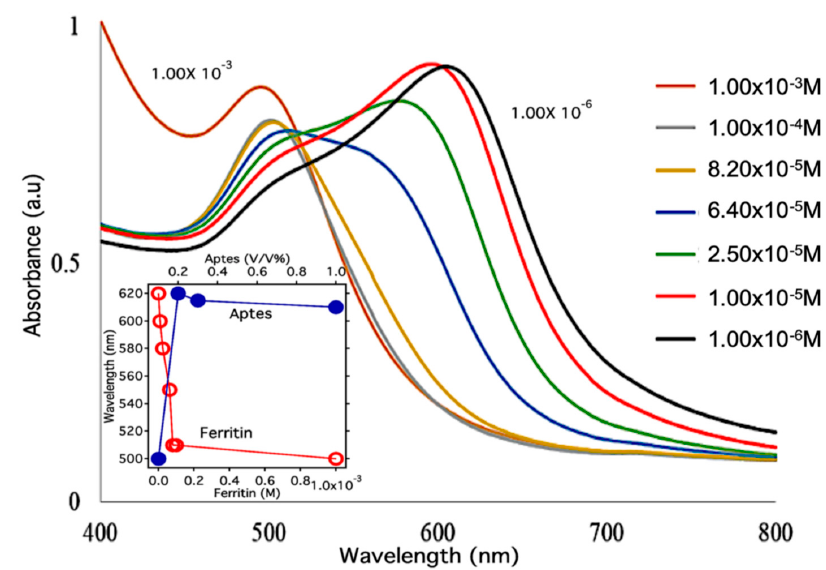
Figure 1. Ultraviolet visible absorbance spectra of gold nanoparticle colloidal solutions with various concentrations of ferritin ranging from 1 × 10 − 3 M to 1 × 10 − 6 M exposed to 3-aminopropyl triethoxysilane (APTES). The inset shows the sensitivity of the peak absorbance to APTES vs. ferritin concentration.